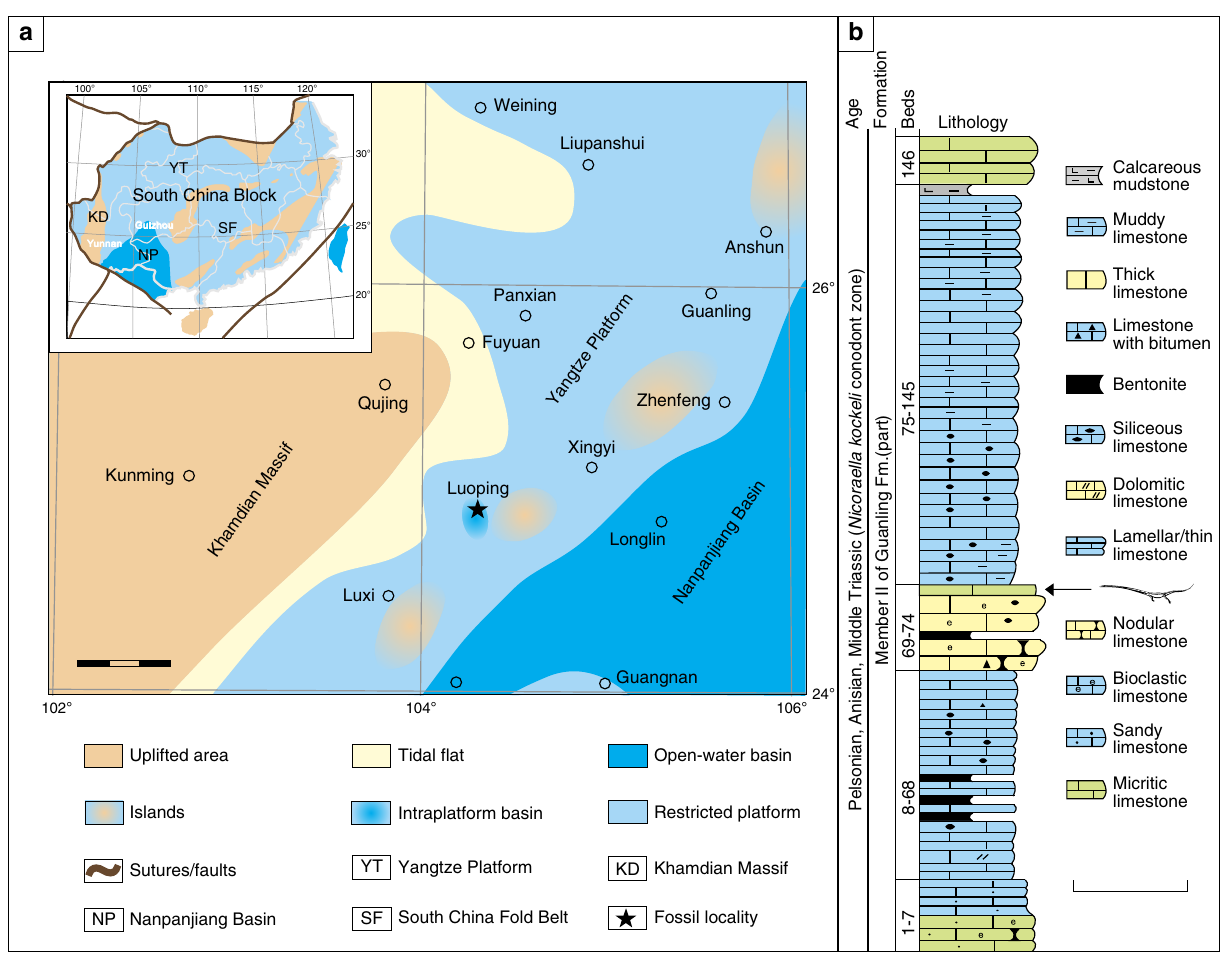
Figure 2 | Locality and horizon of the new Dinocephalosaurus specimen LPV 30280. ( a ) Paleotectonic map showing the location of the Luoping biota where LPV 30280 is preserved 23 . Scale bar, 60km. ( b ) Stratigraphic column of the Dawazi section 23 showing the horizon of LPV 30280. Scale bar,